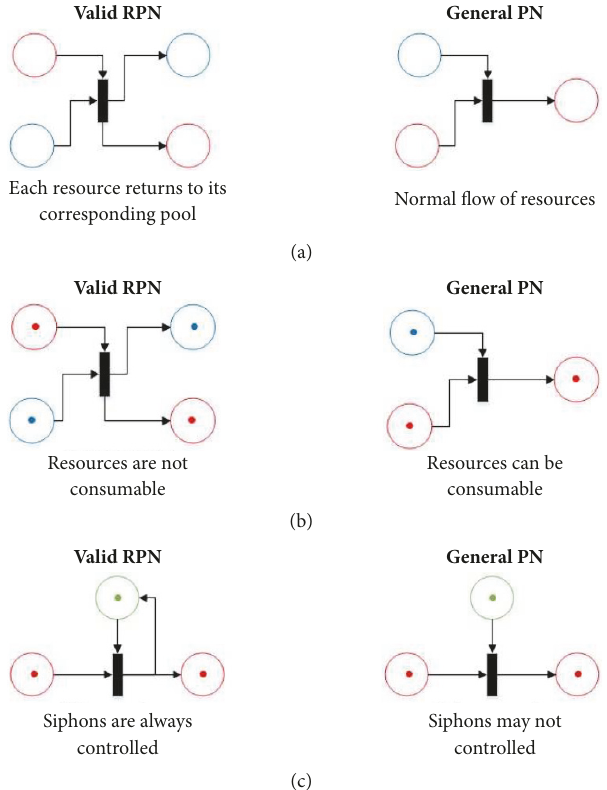
Figure 1: A comparison between RPN architecture ( left hand side ) and regular Petri net ( right hand side